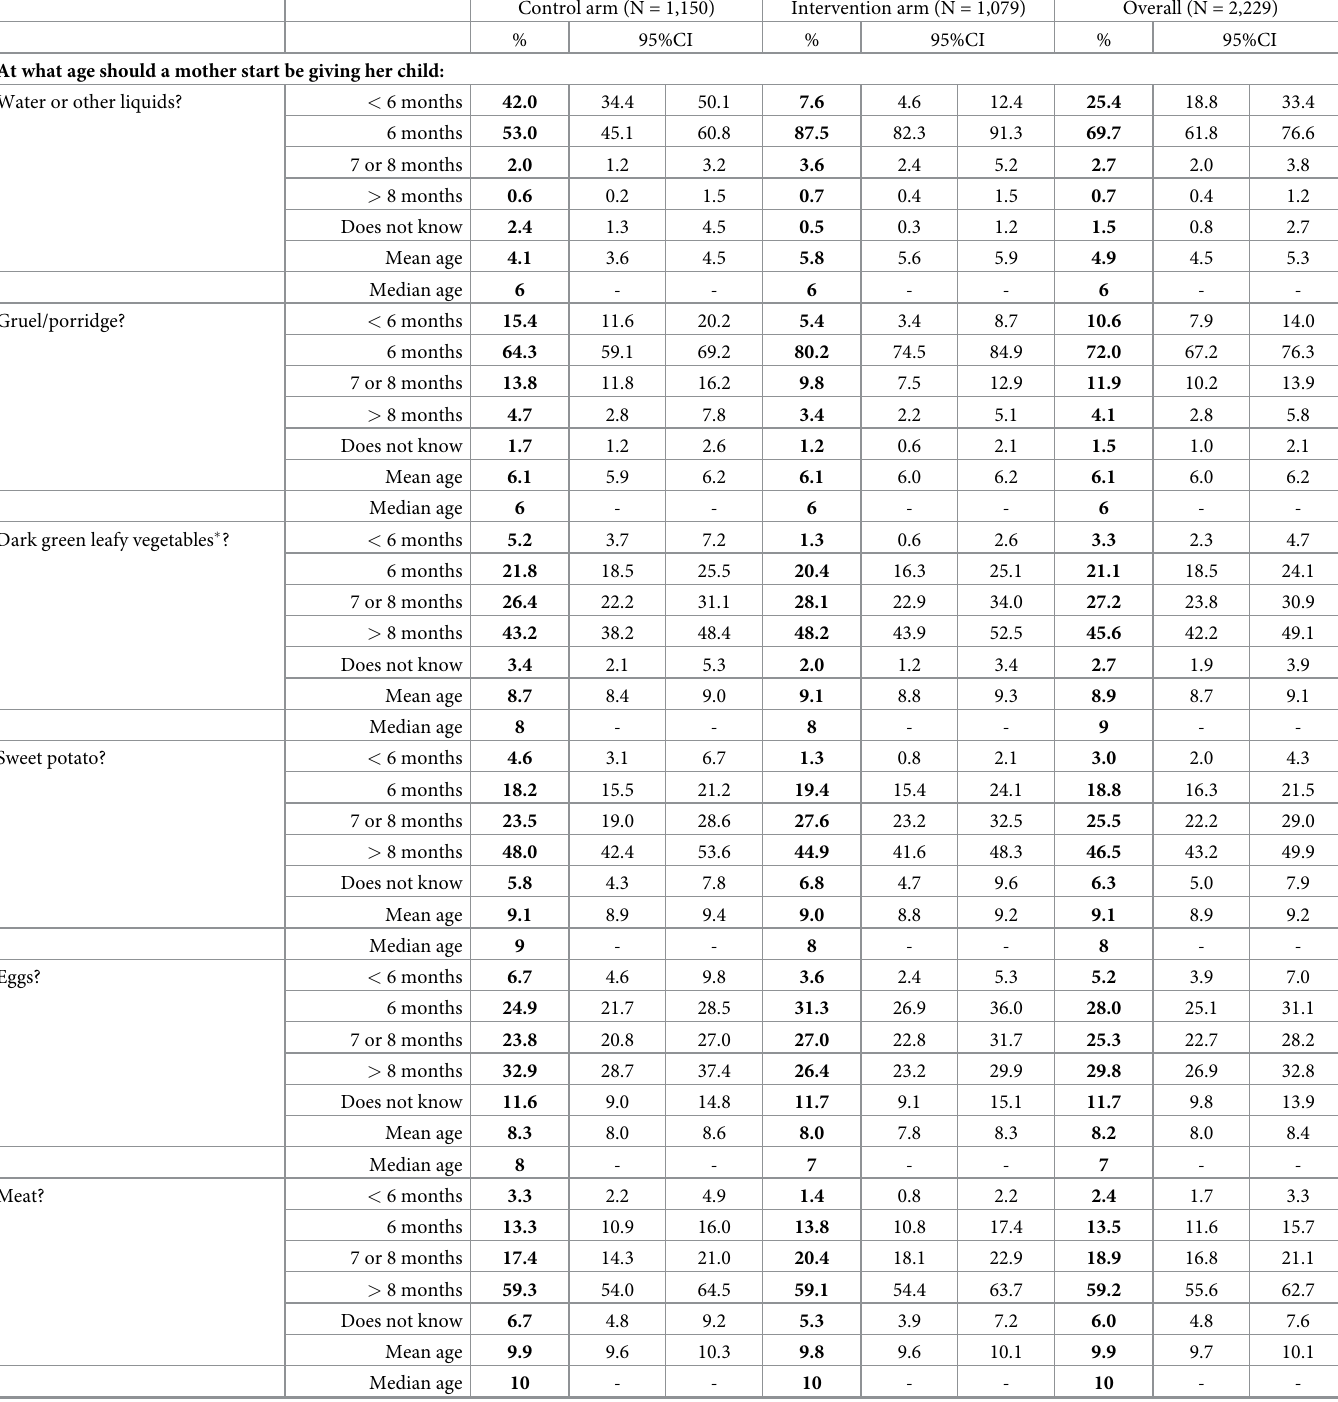
Table 3. Knowledge of timely introduction of complementary foods and minimum meal frequency per trial arm and